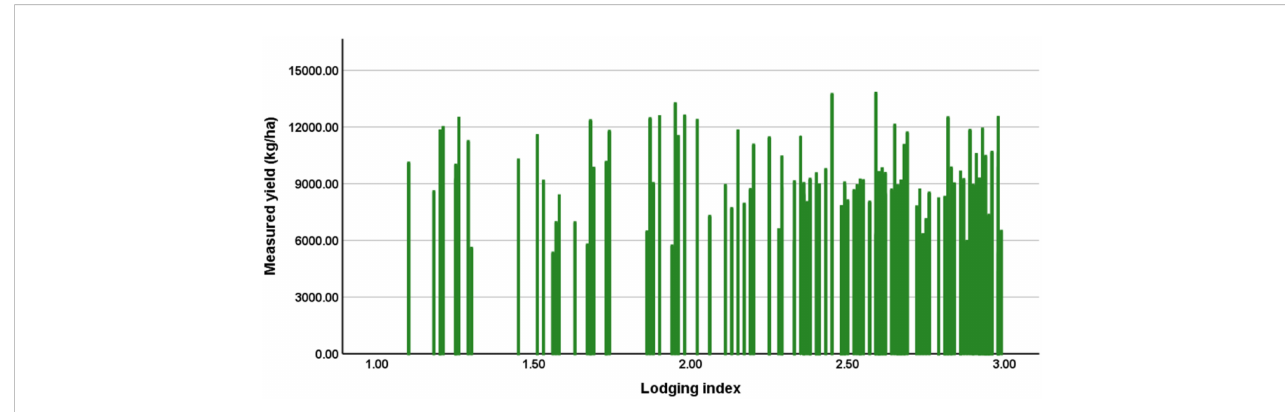
FIGURE 8 One-to-one correspondence between the lodging index and the measured yield of each